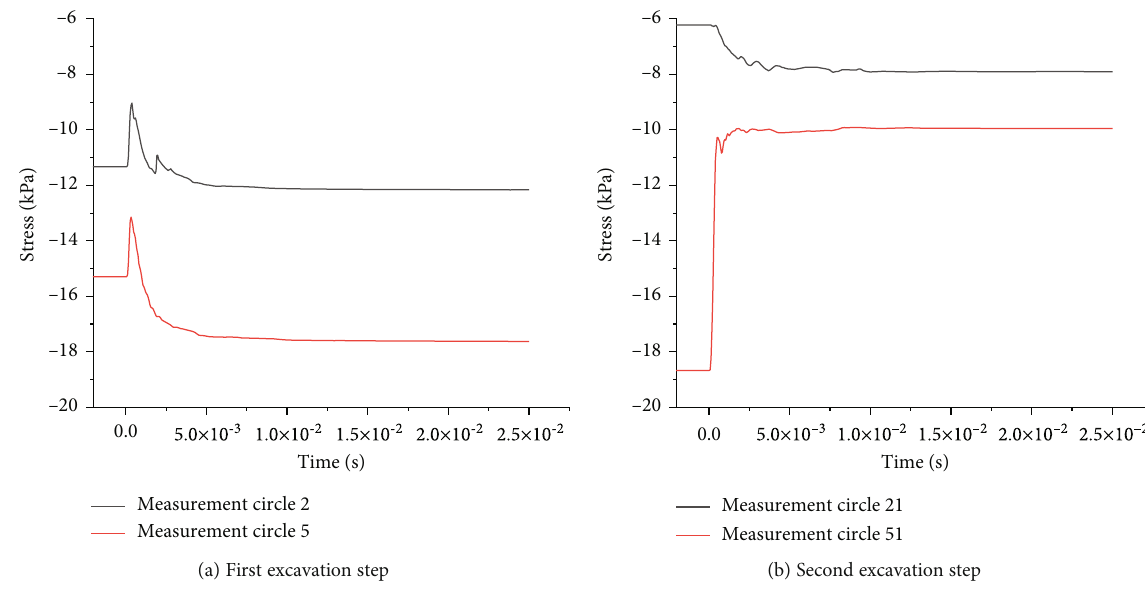
Figure 10: Stress evolution in the overlying strata on the right-hand side of the roof and the left-hand side of the fl oor after the fi rst excavation step (measurement circles 2 and 5, respectively) and after the second excavation step (measurement circles 21 and 51,